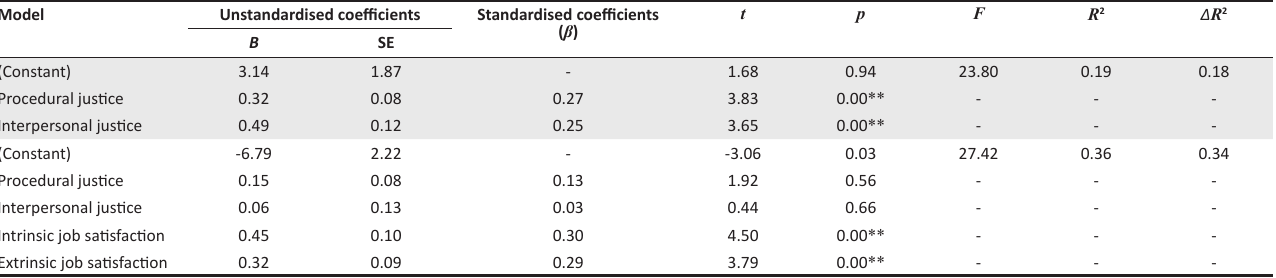
TABLE 6: Multiple regression analysis with employee engagement (work focus) being the dependent variable and procedural justice, interpersonal justice, intrinsic job satisfaction and extrinsic job satisfaction the independent variables.